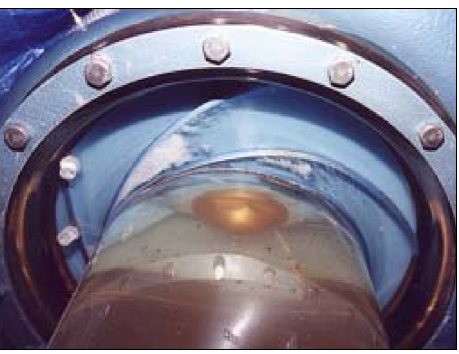
Figure 20: Experimental cavitation observation in two channels of impeller NS32 at capacity greater than that at the best e ffi ciency point.